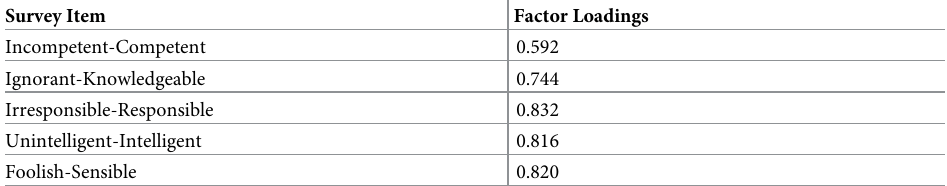
Table 2. Factor loadings for intelligence survey items. Results are for a simple confirmatory factor analysis with no rotation. Factor loadings > 0.32 indicate each item loads onto the intelligence factor [54] Intelligence items were taken from Bartneck et al.